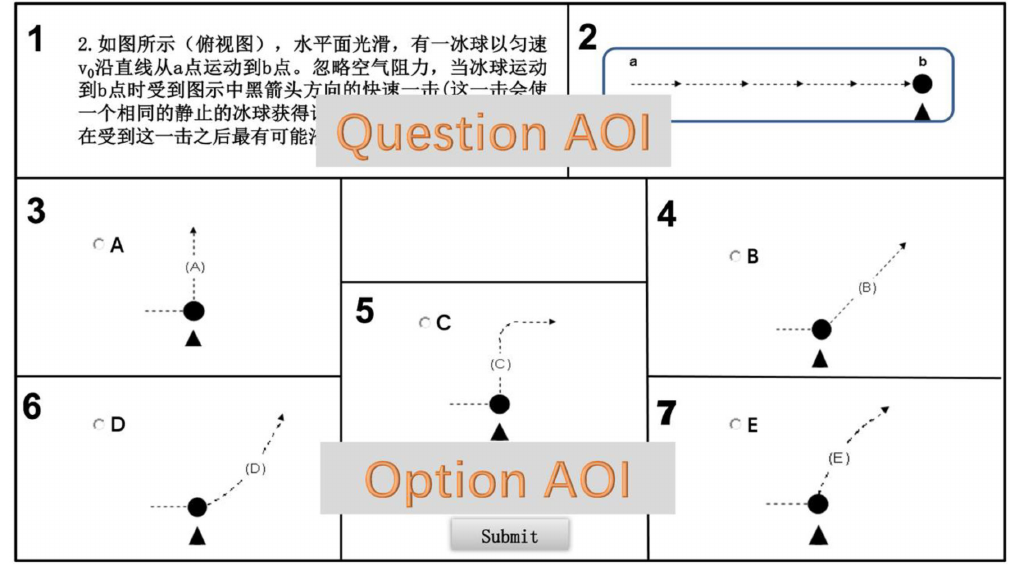
FIG. 1. An example (FCI question 8 [69]) of the multiple-choice problems used in the task. A checkbox was provided next to each option and a submit button was provided at the bottom of the screen. The multiple-choice problems with seven areas of interest were used in the experiment. AOI 1, 2, 3, 4, 5, 6, and 7 indicated seven areas. AOI 1 and AOI 2 were combined as the question AOI. The areas for five alternative responses to the question (AOIs 3, 4, 5, 6, 7) were integrated as the option